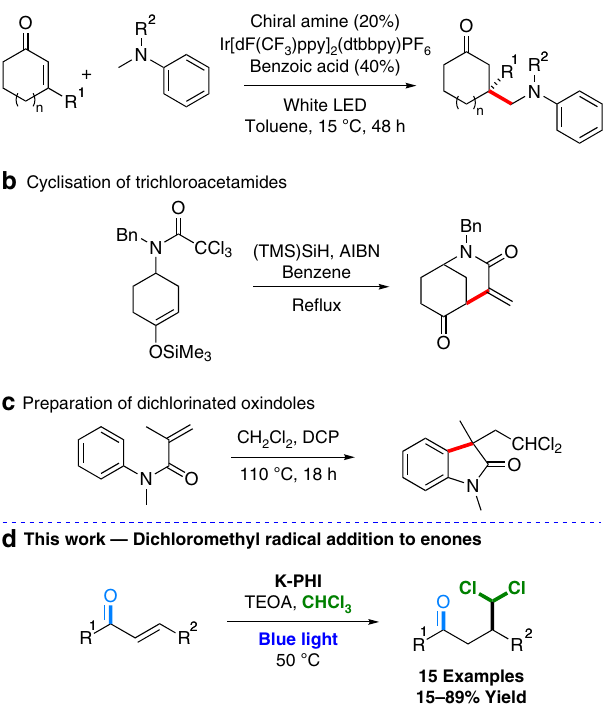
Fig. 1 Previous works related to the designed reaction are presented. a Conjugate addition to enones. b Cyclisation of trichloroacetamides. c Synthesis of dichlorinated oxindoles. d Photocatalytic reaction developed in this